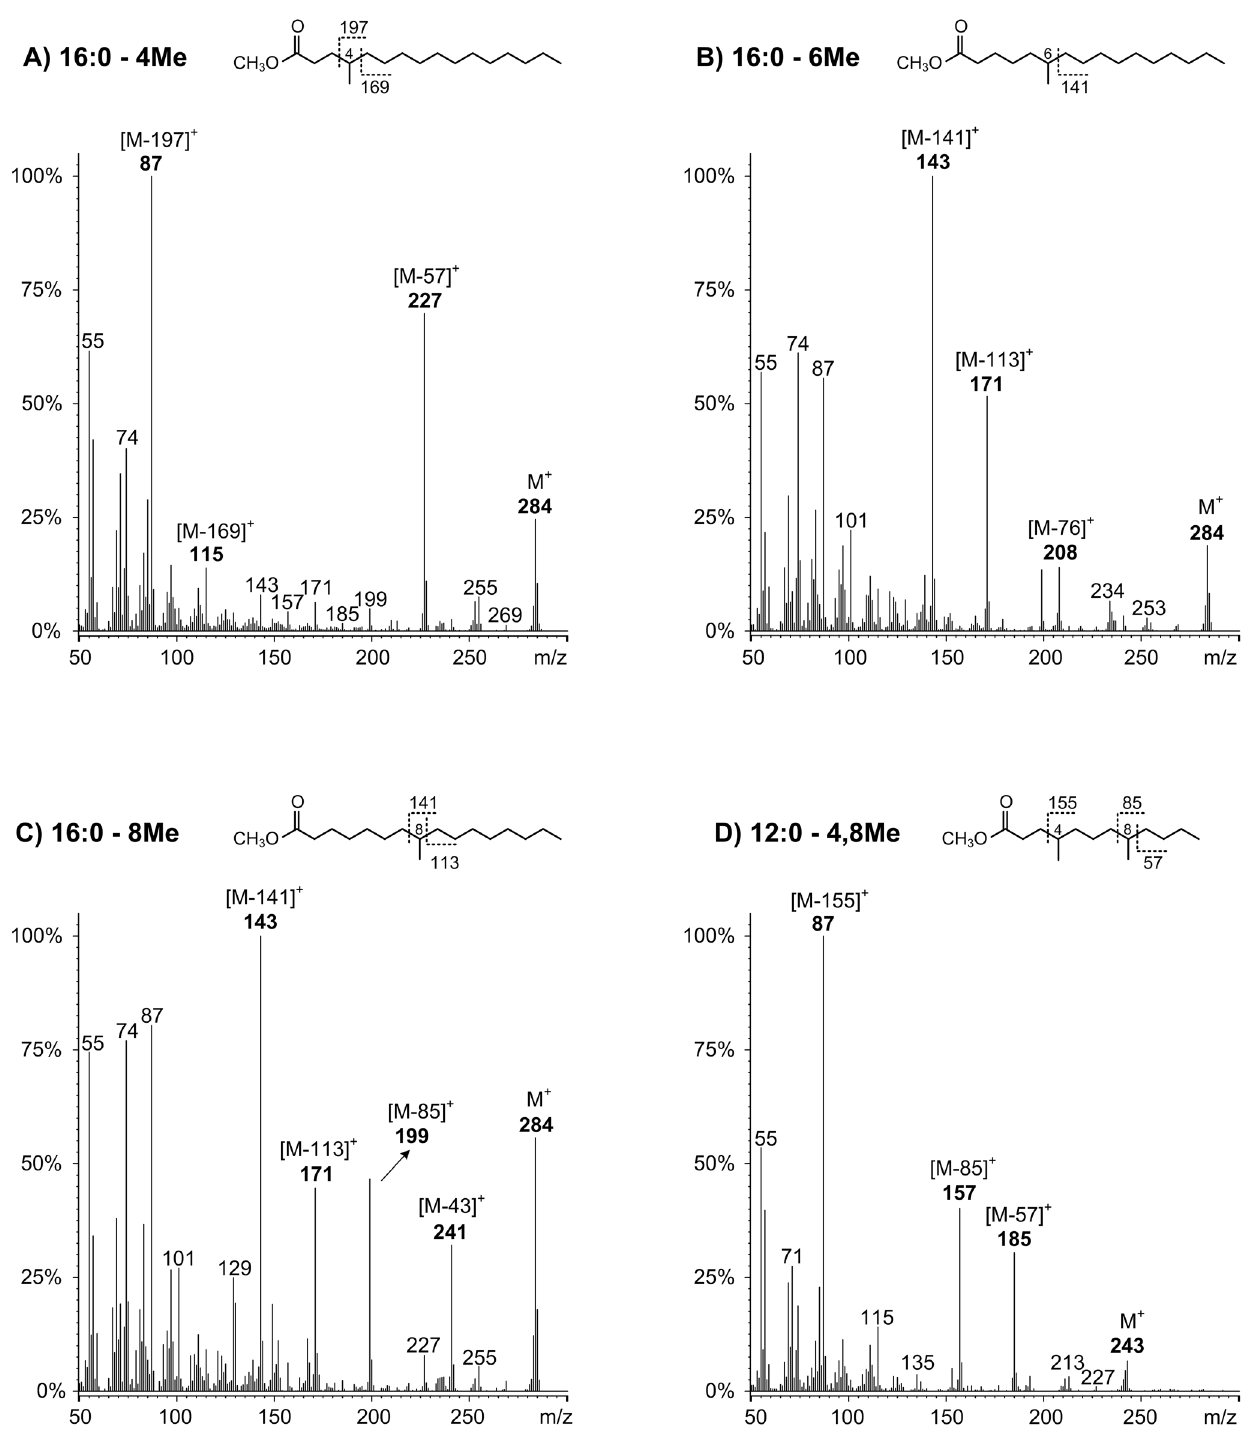
Figure 3. Electron impact mass spectra of the: A) 16:0 – 4Me; B) 16:0 – 6Me; C) 16:0 – 8Me; and D) 12:0 – 4,8Me branched chain fatty acids in the fat tail of Damara Ram lambs.